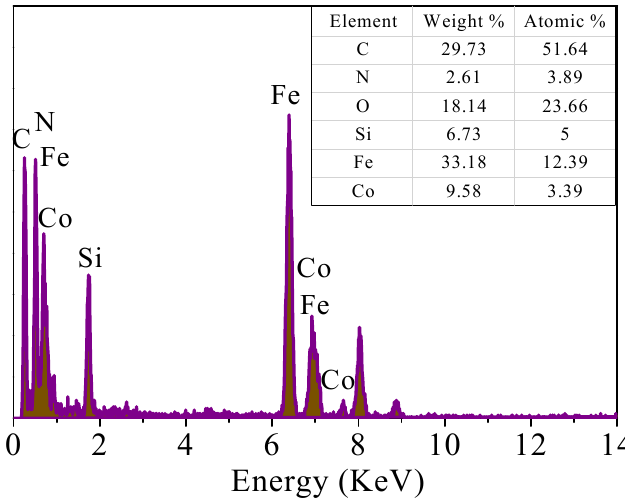
Figure 4. Energy-dispersive spectrometry (EDS) elemental analysis of CoFe 2 O 4 @SiO 2 -Ppy.